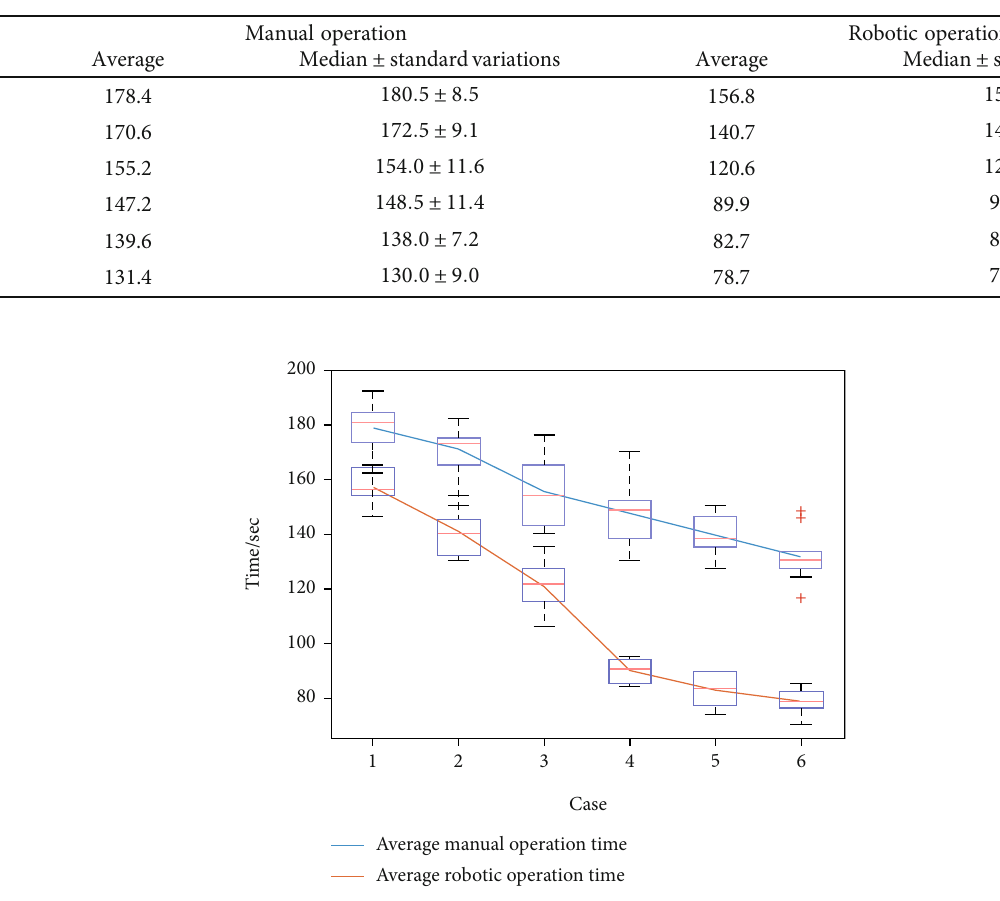
Figure 14: Time comparison between the manual and robotic operations in the phantom